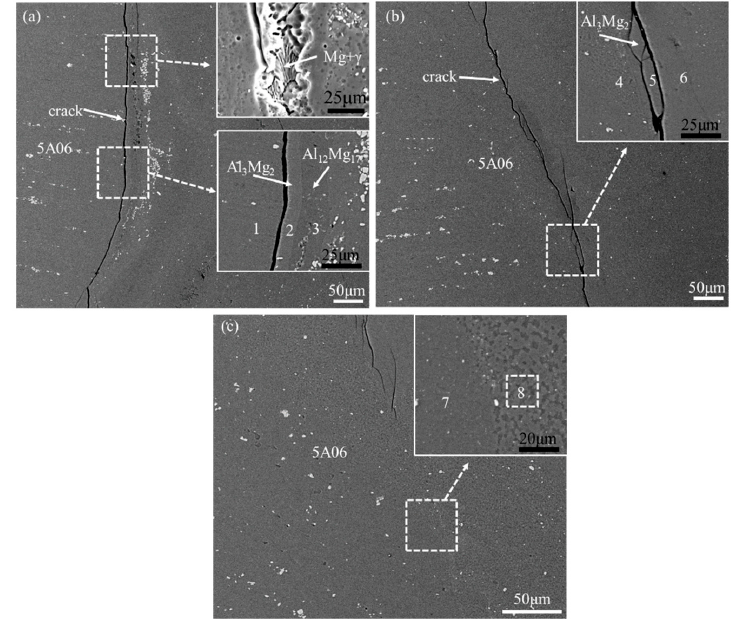
Materials 2019 , 12 , x FOR PEER REVIEW Figure 6. SEM micrograph of the 5A06 Al alloy interface: ( a – c ) represent the location E, F and G, respectively.